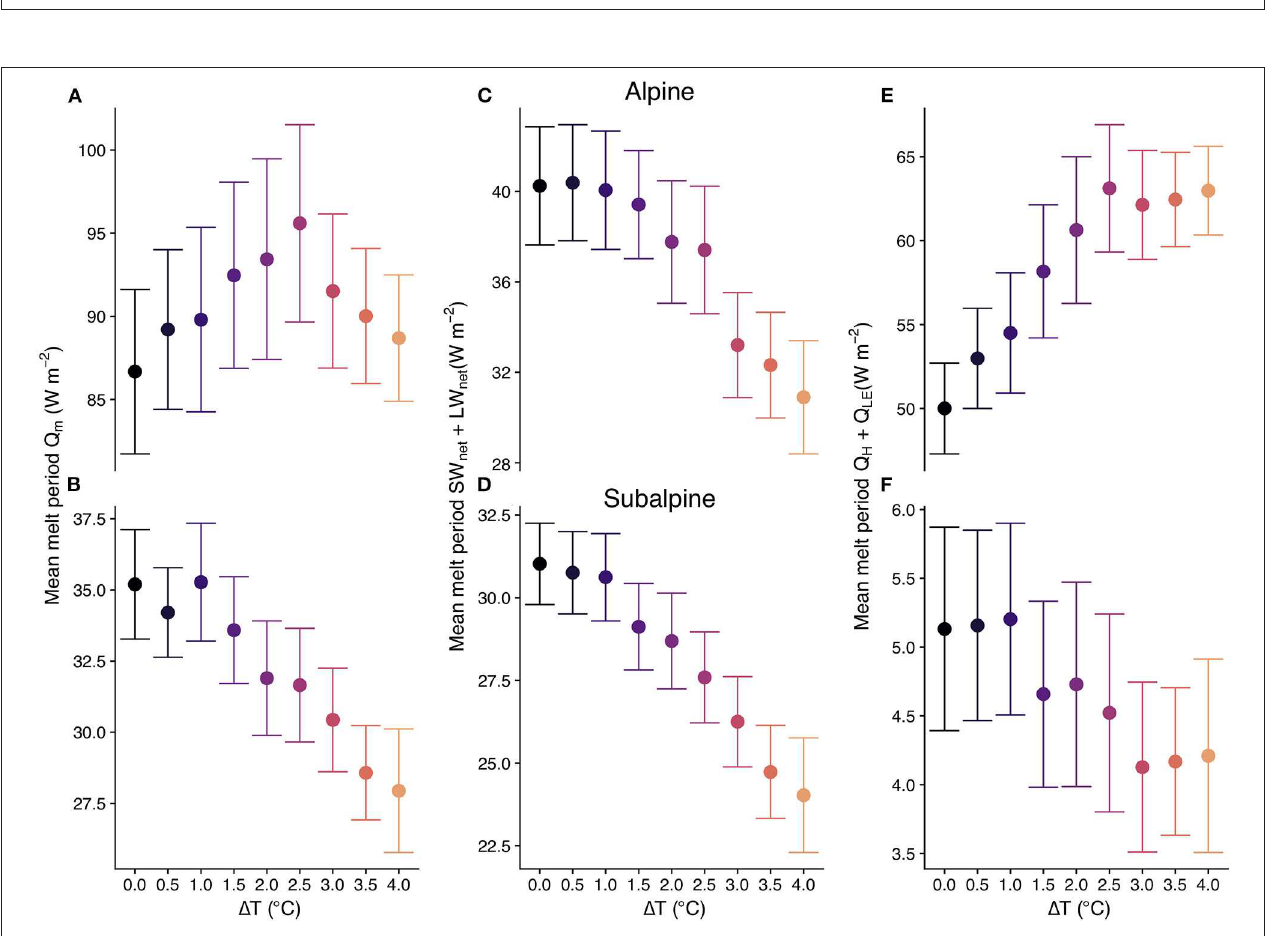
FIGURE 6 | Mean melt period Q M (A,B) , radiative fluxes (C,D) , and turbulent fluxes (E,F) in the alpine (top) and subalpine (bottom). Here the melt period is defined as the time between peak SWE and the snow-off date. The points are the average hourly flux value across the melt periods from the 23 simulation years with whiskers representing ± 1 standard error for each 1 T scenario. Note: y-axis ranges are different for each subplot.